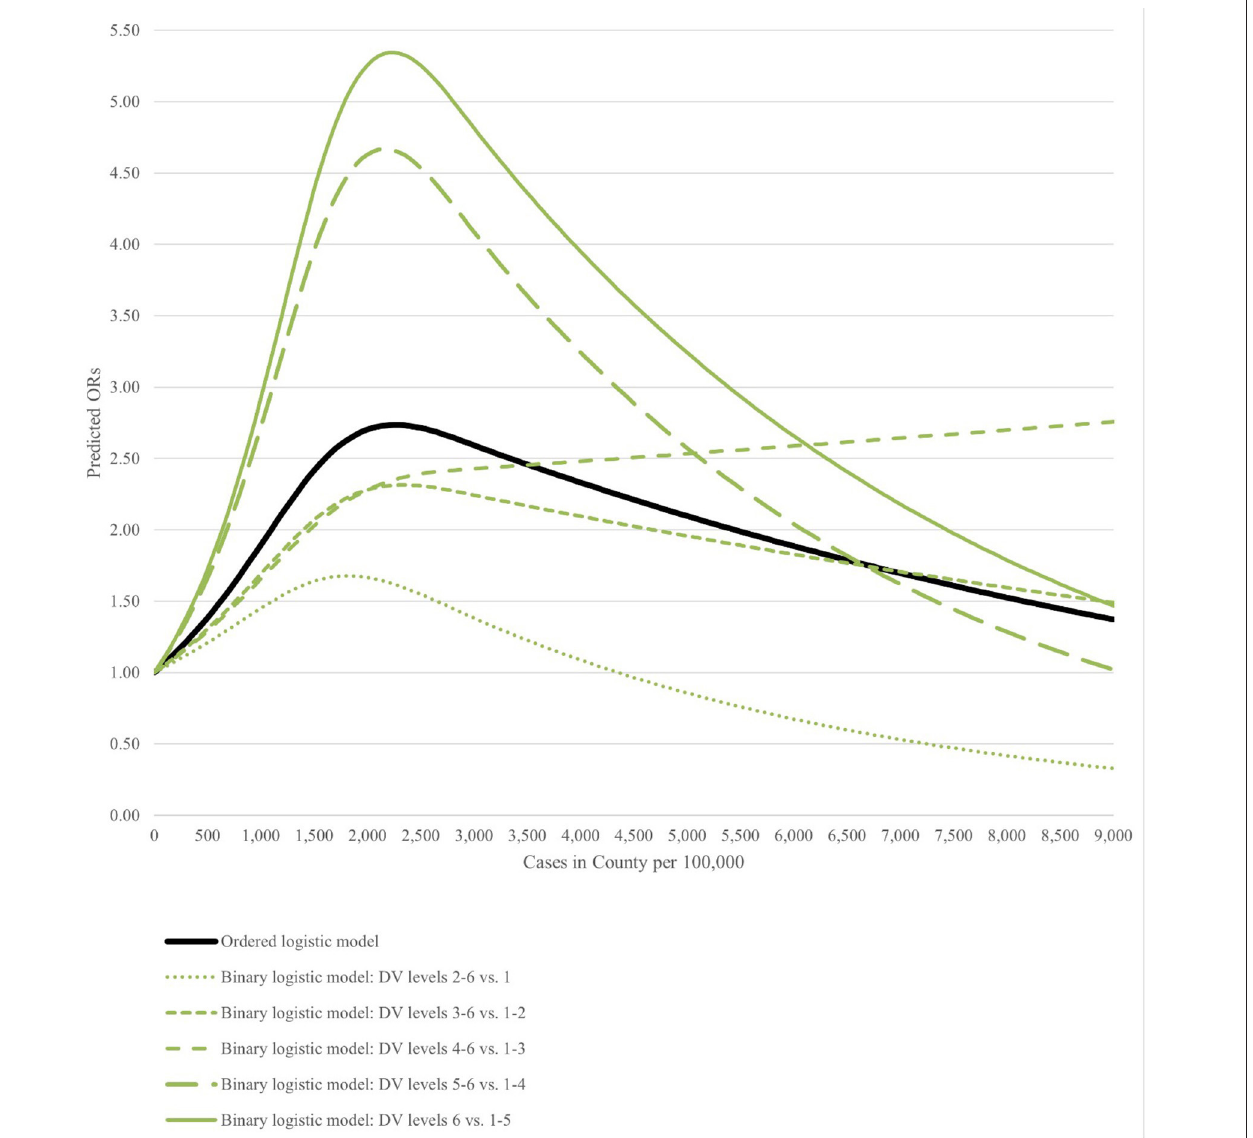
FIGURE 2 | Predicted odds ratio by the COVID-19 incidence rate in the